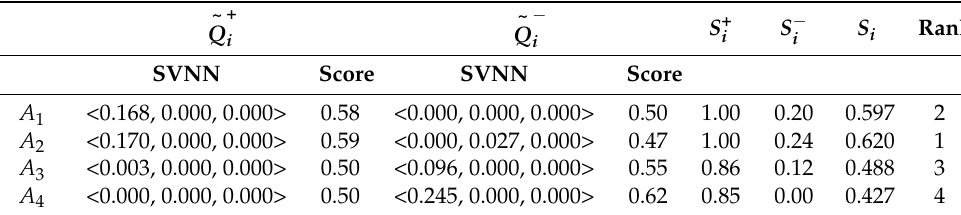
Table 7. Computational details and ranking order of considered tablets.